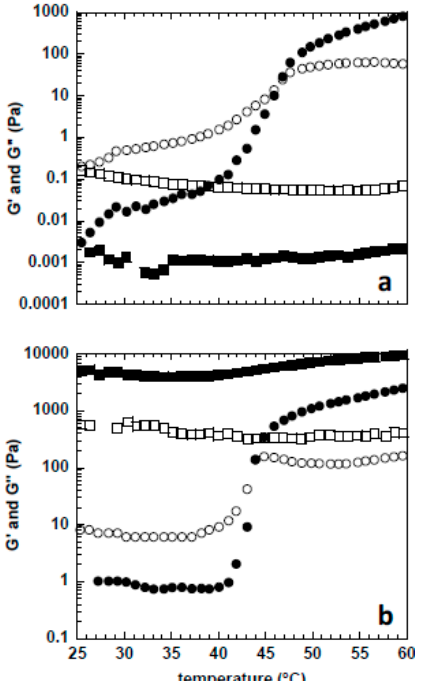
Figure 3. Viscoelastic parameters determined by mechanical rheometry. G ′ (full symbols) and G ″ (empty symbols) were obtained for samples with (squares) and without (circles) urea after a temperature sweep from 25 to 60 °C (heating rate of 1 °C/min) at a constant shear stress of 10 Pa and frequency of 0.1 Hz. ( a ) 5 wt % MCC and ( b ) 10 wt % MCC dissolved in 8 wt % NaOH(aq.)/12 wt % urea.